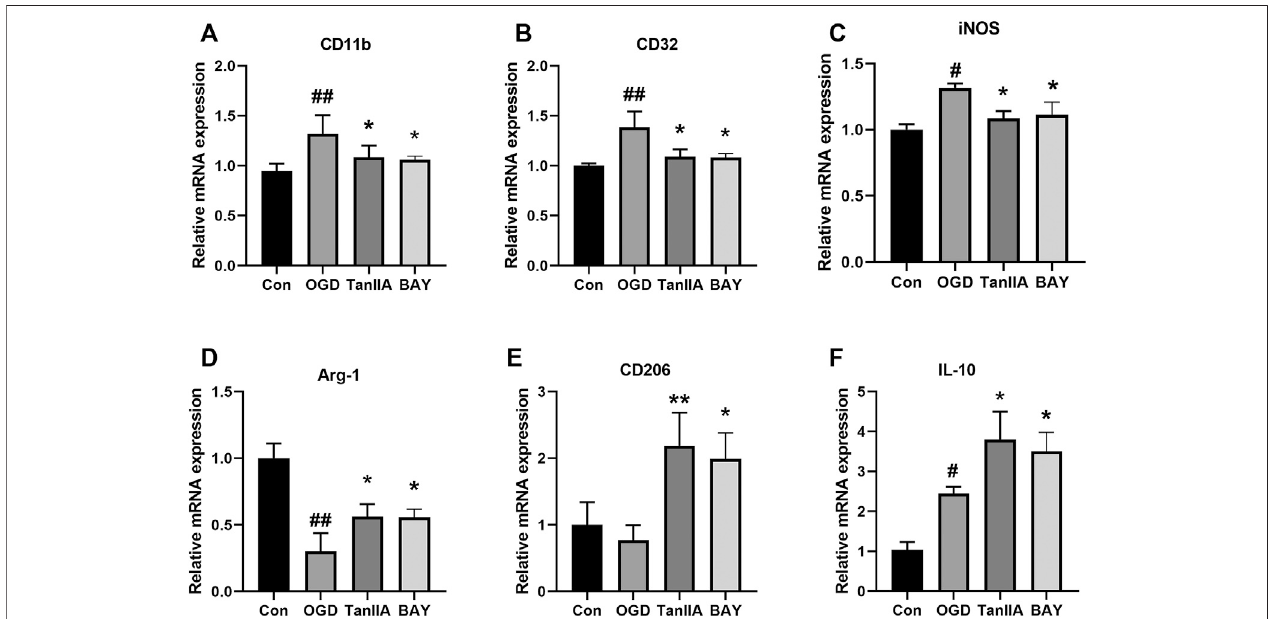
FIGURE 6 | Effect of Tanshinone IIA on polarization-related mRNA expressions after OGD in BV2 cells. OGD-induced BV2 cells were treated with Tanshinone IIA. Quantitative RT-PCR was used to assess the mRNA expression levels of M1 microglia markers: CD11b (A) , CD32 (B) , iNOS (C) , and M2 microglia markers: Arg-1 (D) , CD206 (E) , IL-10 (F) . ## p < 0.01, compared with the Con group, * p < 0.05, compared with the OGD group. Con, control group; OGD, oxygen-glucose deprivation; TanIIA, Tanshinone IIA. BAY, BAY-11-7082, a NF- κ B inhibitor, n (cid:1)